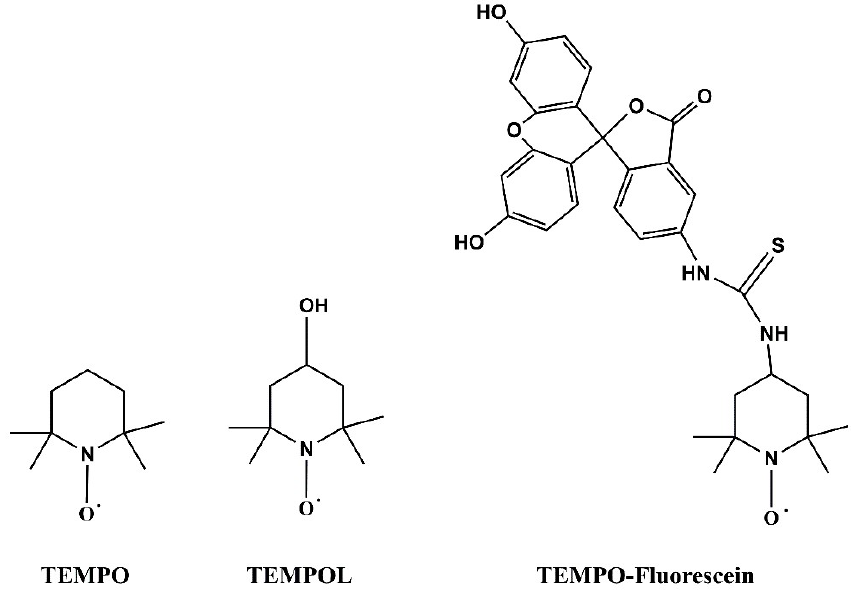
Figure 1. The structures of the spin probes studied.